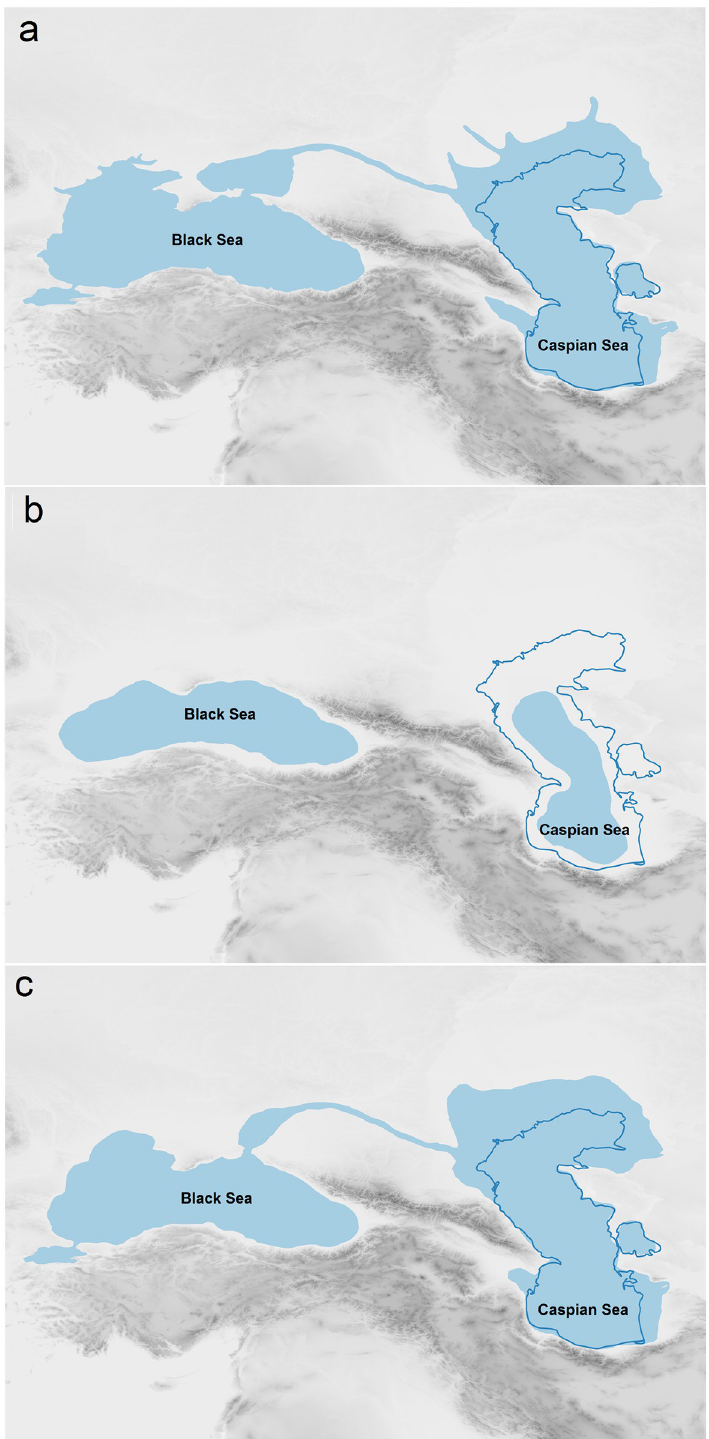
Fig 7. Reconstruction of Caspian Sea level at late Pleistocene. A: MIS 5e (Late Khazarian transgression), B: MIS 4 (Atelian regression), C: MIS 3 (Khvalynian transgression).